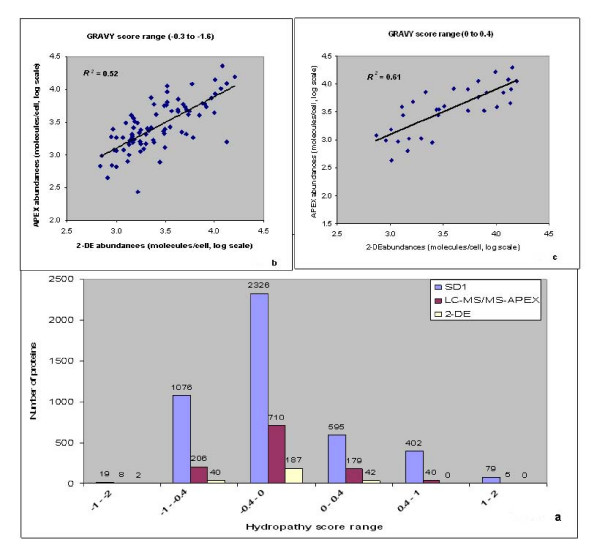
Correlation of protein abundances estimated by APEX vs. 2-DE based on hydropathy score. Hydropathy (GRAVY) score of a protein was calculated as the arithmetic mean of the sum of the hydropathic indices of each amino acid. The left end of the scale in Fig. 5a represents hydrophilic proteins, and the right end of the scale represents hydrophobic proteins. Within a particular hydropathy range, the number of proteins quantitated by APEX and 2-DE were compared against all protens predicted for Sd197. Correlation of protein abundances estimated by APEX vs. 2-DE decreased for very hydrophobic (R2 = 0.61) and also for very hydrophilic proteins (R2 = 0.52) compared to the overall abundance correlation.